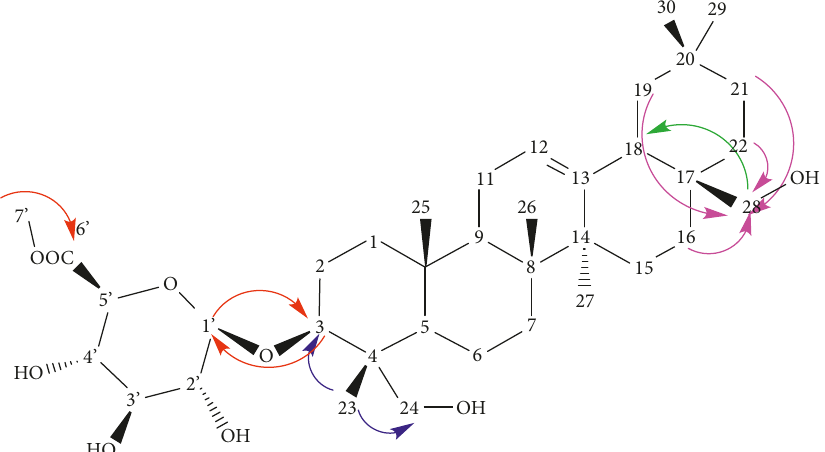
Figure 2: Structure and HMBC and TOCSY correlations of compound (Fig. S14, Supplementary Materials). Subfraction Fr-C-5 was